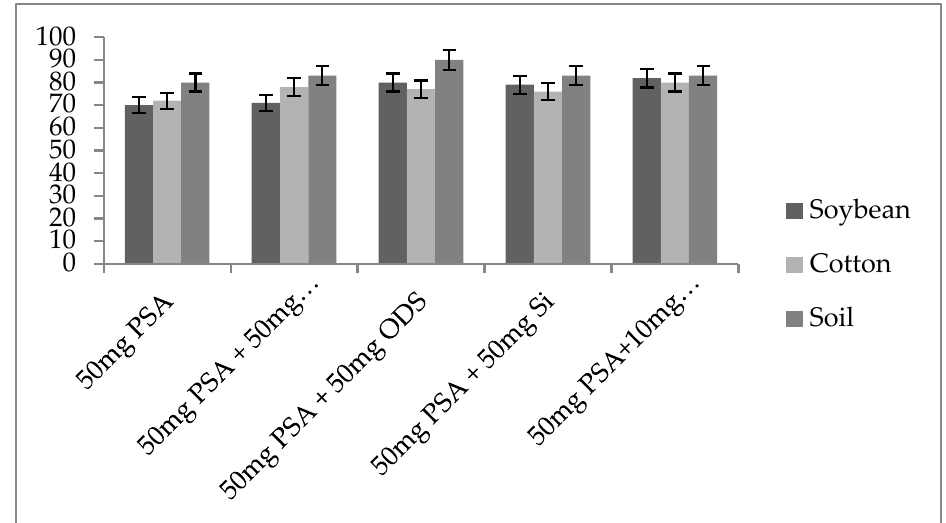
Figure 3. Clean ‐ up capabilities of different d ‐ SPE sorbents for spinosyn ‐ J at 25 ng g − 1 spiking level. Figure 3. Clean-up capabilities of different d-SPE sorbents for spinosyn-J at 25 ng g − 1 spiking level. Both spinosyn-J and spinosyn-L could be analysed by a single chromatographic run of 16 min. Spinetoram could be detected at 10 ng g − 1 with the instrumental conditions used in this experiment. Linearity of the calibration curve was established for both